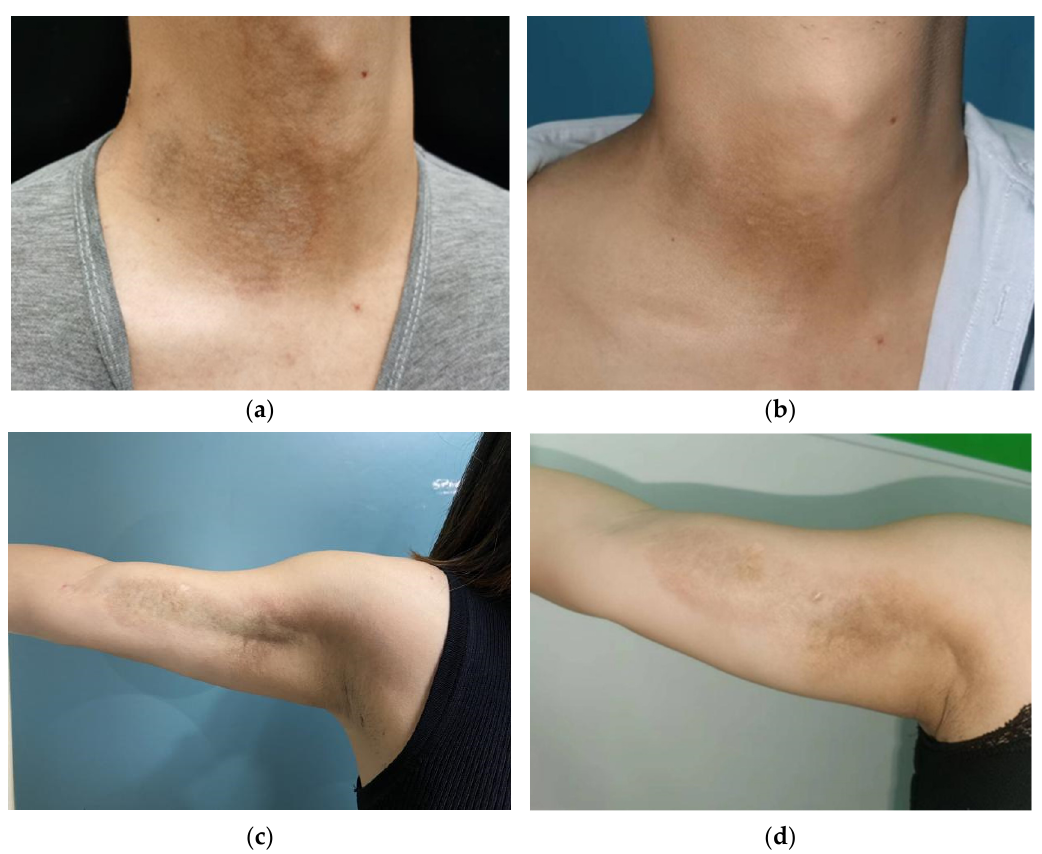
Figure 2. Clinical photography of patients. ( a ) Patient 4 weeks before treatment with ablative frac- tional laser-assisted delivery of methotrexate. ( b ) Patient 4 weeks after treatment with ablative frac- tional laser-assisted delivery of methotrexate. ( c ) Patient 4 weeks before treatment with ablative fractional laser. ( d ) Patient 4 weeks after treatment with ablative fractional laser.